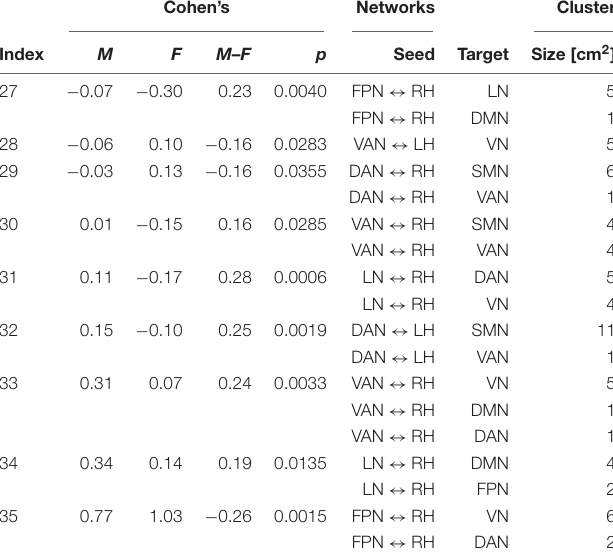
For example, the row indexed by the numeral 1 in the table lists data for FC between the FPN (seed network) and a statistically significant cluster, with an area of ∼ 11 cm 2 , located in the left-hemisphere portion of the SMN (target network). The effect sizes of FC changes are listed; for example, for index 1, Cohen’s d for males is d M = − 2.14 and Cohen’s d for females is d F = − 1.89, with an effect size difference d M − d F = −